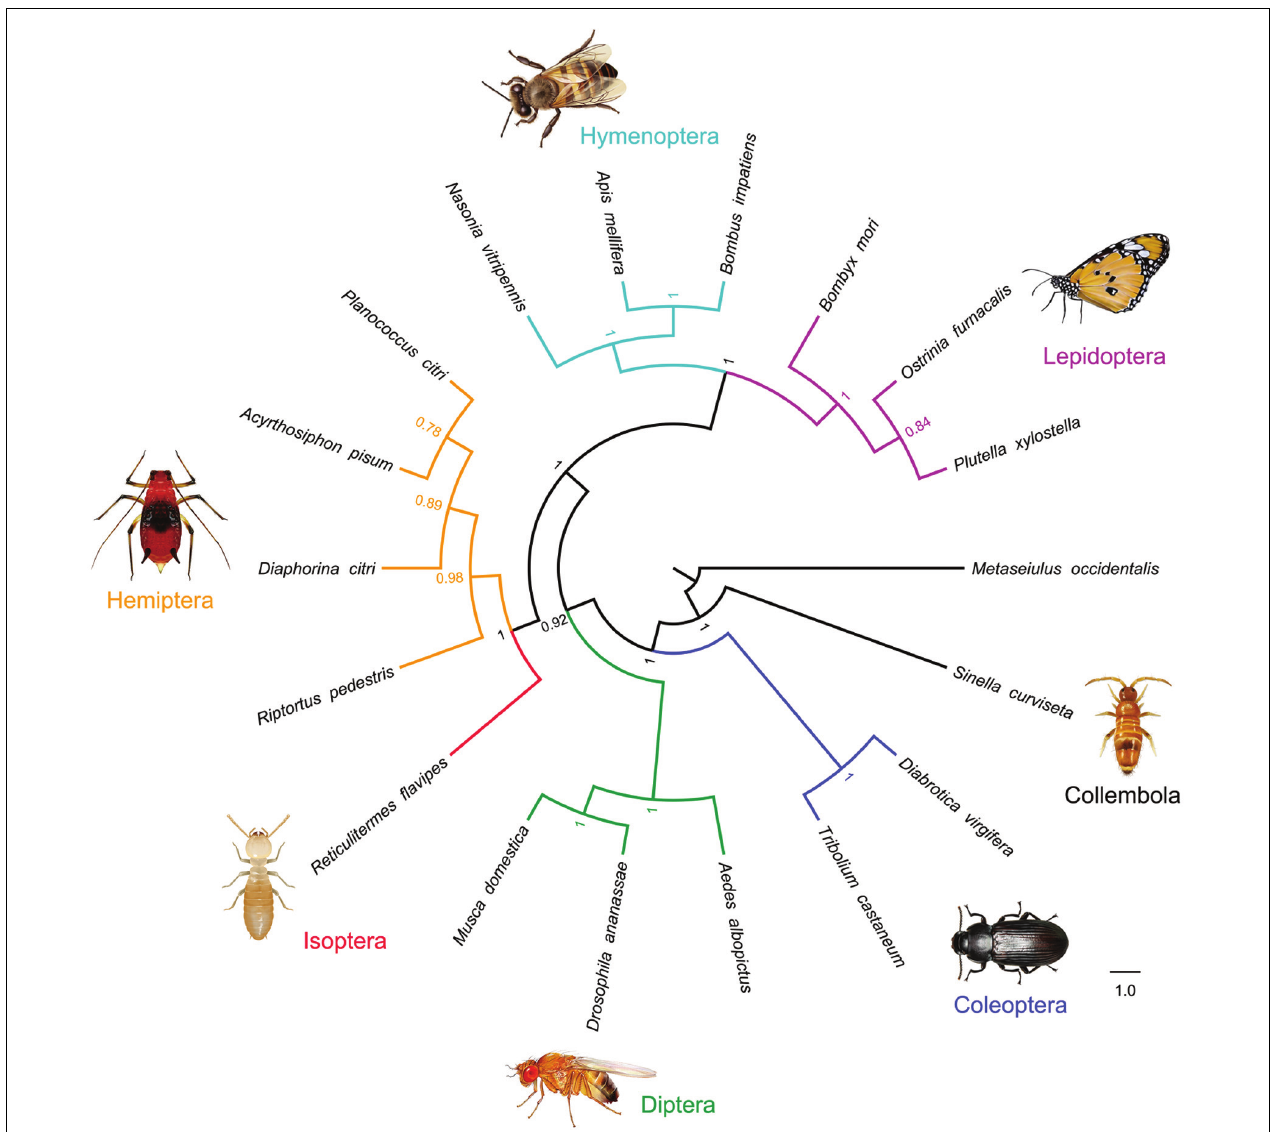
FIGURE 2 | Phylogenetic analysis of v-ATPase A in insects. Amino acid sequences were aligned using the MAFFT algorithm in the TranslatorX online platform. Alignments were then checked and corrected manually in MEGA v6.0. The WAG + G model was the best-fit amino acid substitution model selected by ProtTest 2.4 under AIC criteria. MrBayes v3.2.3 with WAG + G model was used for the phylogenetic